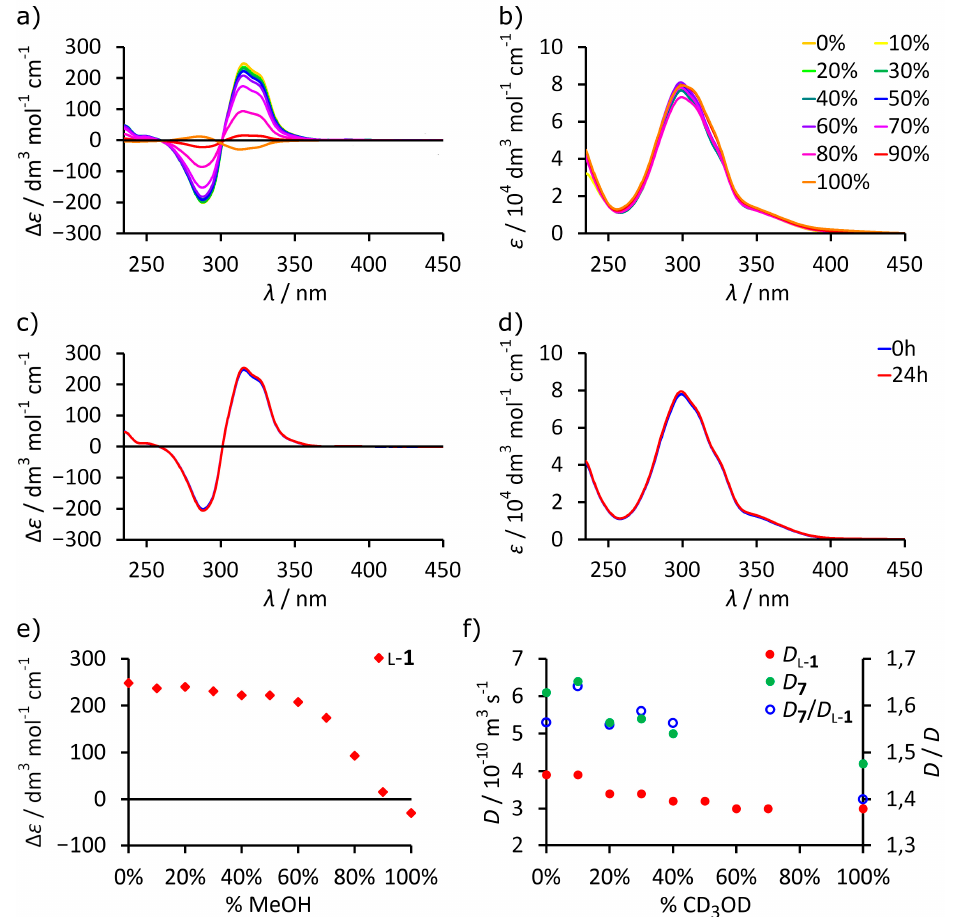
Figure 5. Experimental UV/ECD and DOSY spectra for L - 1 in solvent mixtures at 25 °C: ( a ) ECD spectra in CHCl 3 /MeOH; ( b ) UV spectra in CHCl 3 /MeOH; ( c ) time-dependent ECD spectra in CHCl 3 /MeOH 30%; ( d ) time-dependent UV spectra in CHCl 3 /MeOH 30%; ( e ) changes in ECD intensities dependent on the amount MeOH in CHCl 3 (all intensities of ECD and UV spectra calculated for the concentration of cavitand); ( f ) changes in diffusion coefficients ( D ) from DOSY spectra dependent on the amount CD 3 OD in CDCl 3 .